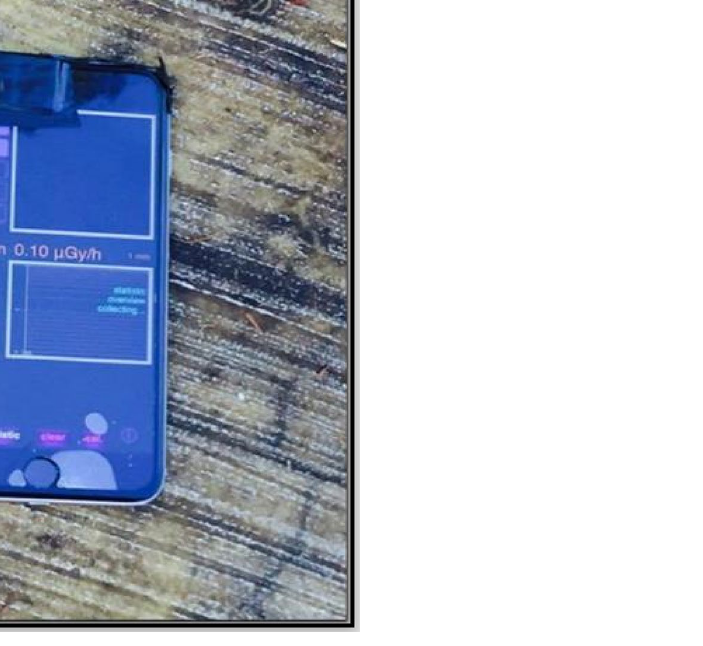
Figure 12. Measurement setup without